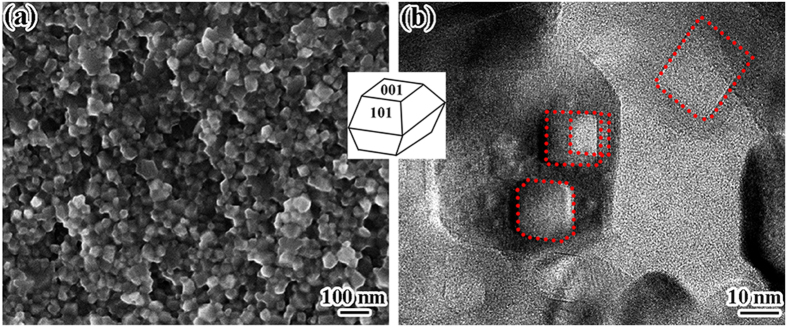
(a) SEM and (b) TEM image of HT-2. The inset is a model of equilibrium shape of anatase TiO2 with exposed {101} and {001}.